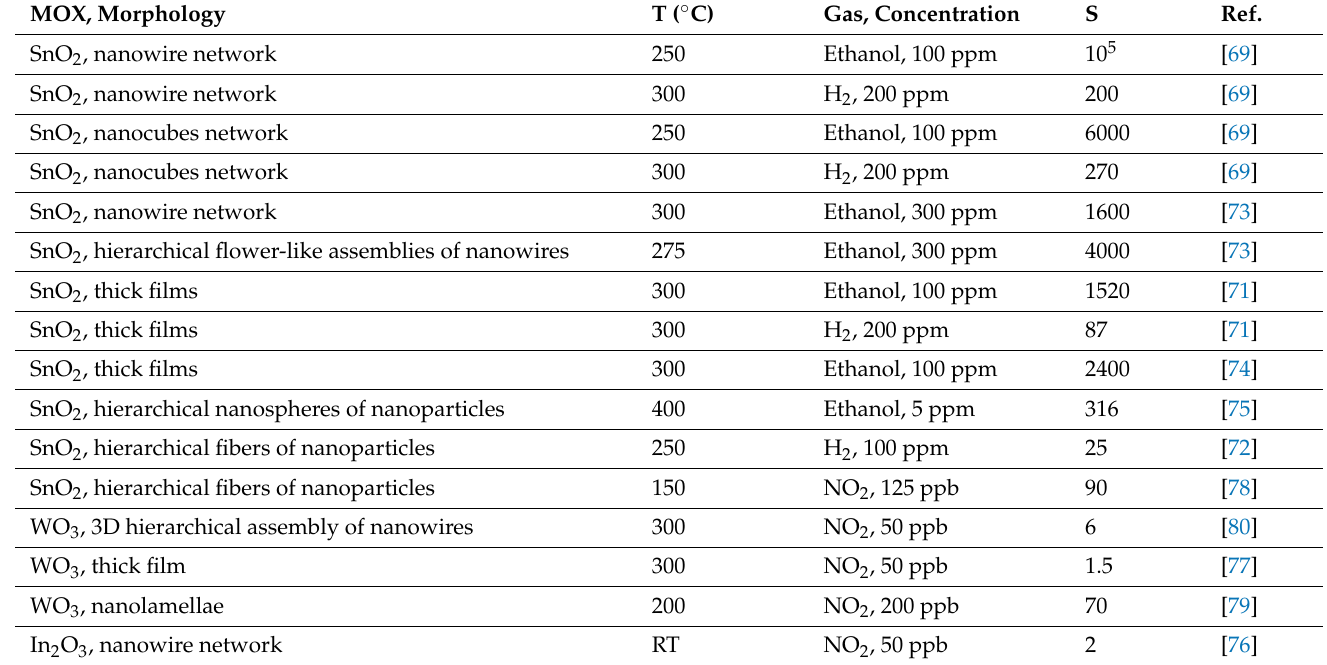
Table 1. Chemiresistors based on pure (neither doped nor functionalized) metal oxide (MOX) nanoparticles and nanowires. The response intensity S is calculated as S = R gas /R air for NO 2 and as S = R air /R gas for other compounds at the sensor temperature T. Gas concentrations are expressed in parts per million (ppm) or parts per billion (ppb), and, in the T column, RT stands for ‘room